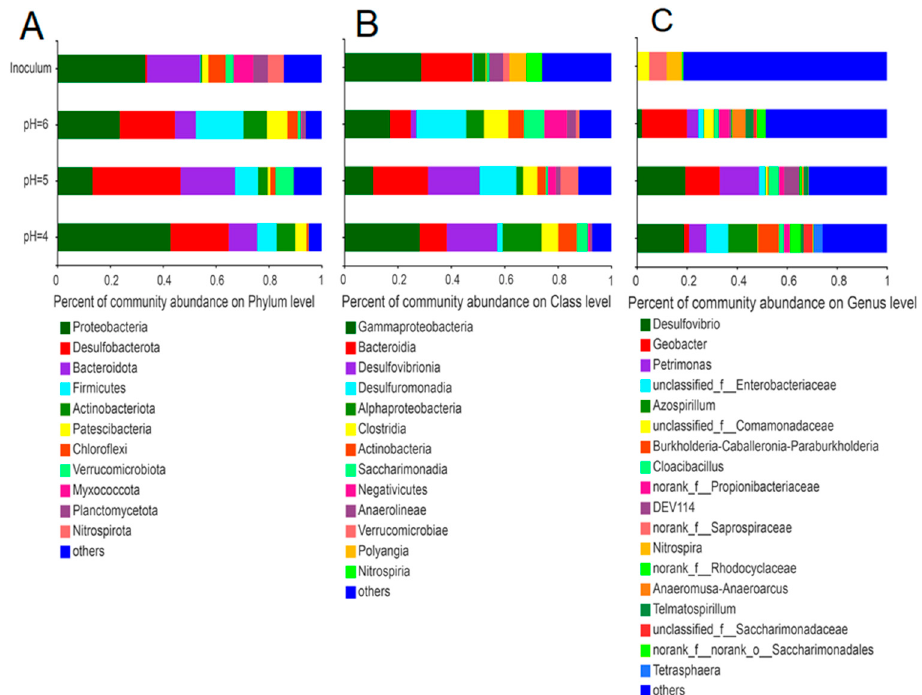
Figure 5. Differences in microbial community structure at the phylum ( A ), order ( B ), and genus ( C ) levels for electroactive biofilms at different pH.